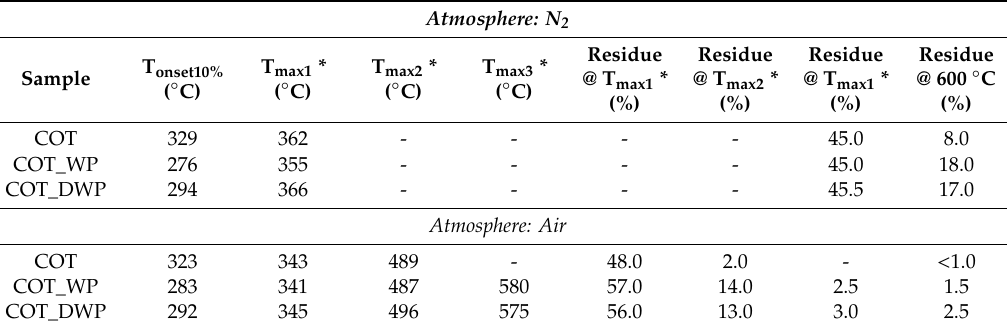
Table 1. Thermogravimetric data of untreated and WP-treated cotton fabrics.